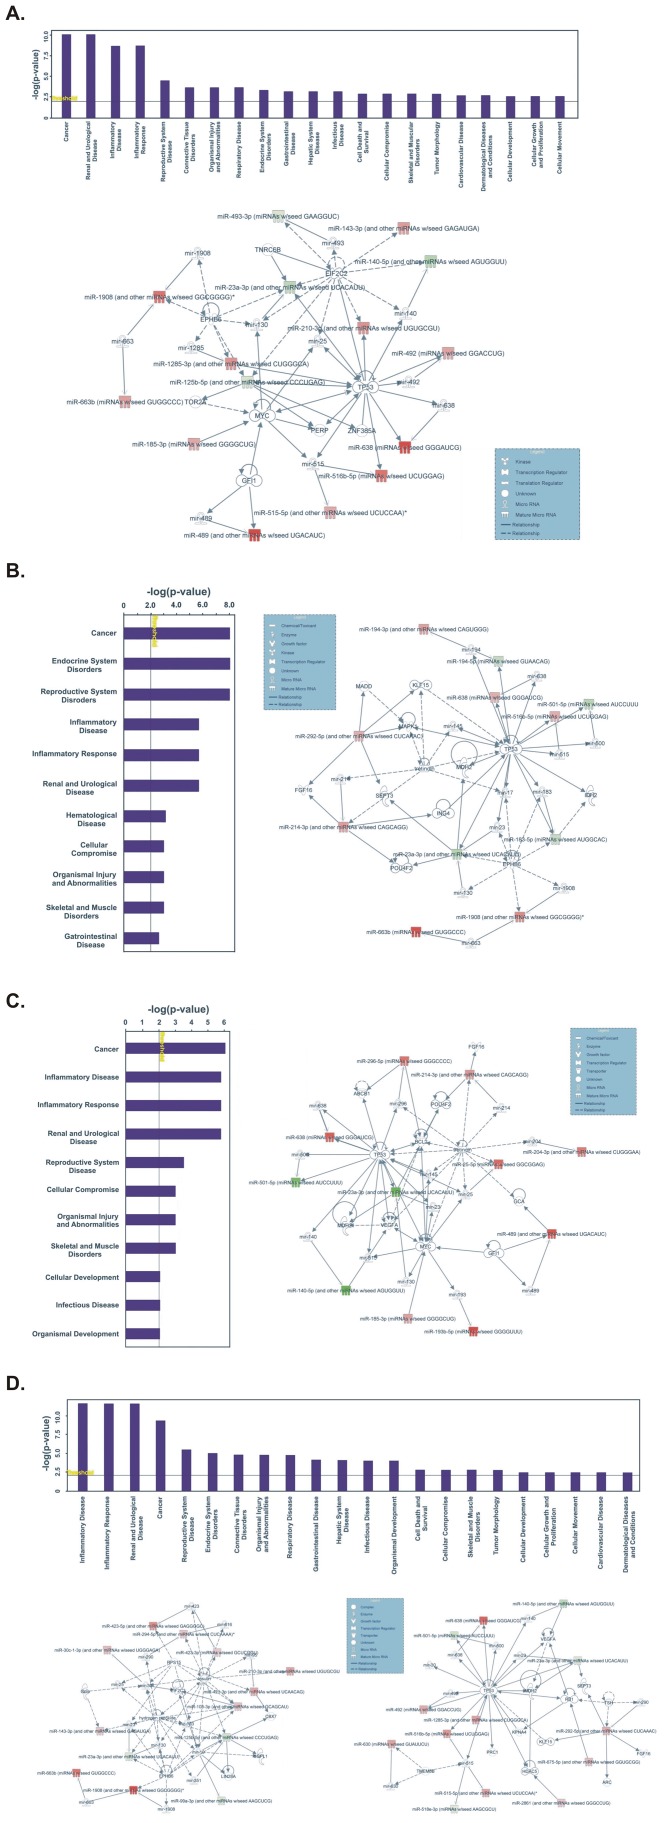
Ingenuity pathway analysis (IPA).A. In ccRCC, the most important biological functions of the top deregulated miRNAs were: 1) Cancer (p = 8.71E-11-4.91E-02); 2) Renal and Urological Disease (p = 8.71E-11-2.12E-09); 3) Inflammatory Disease (p = 2.12E-09-2.14E-03); 4) Inflammatory Response (p = 2.12E-09-2.4E-04) and 5) Reproductive System Disease (p = 3.37E-05-2.58E-02). The associated functions of the major miRNA network (score = 30) were: Inflammatory disease, inflammatory response, renal inflammation. Argonaute RISC catalytic component 2 (EIF2C2), tumour protein p53 (TP53), v-myc myelocytomatosis viral oncogene homolog (MYC) and EPH receptor B6 (EPHB6) constituted some of the major central nodes in this network. B. In papRCC, the most important biological functions of the top deregulated miRNAs were: 1) Cancer (p = 9.4E-09-4.15E-02); 2) Endocrine System Disorders (p = 9.4E-09-4.54E-02); 3) Reproductive System Disease (p = 9.4E-09-5.11E-03); 4) Inflammatory Disease (p = 2.17E-06-2.17E-06) and 5) Inflammatory Response (p = 2.17E-06-1.65E-03). The associated functions of the major miRNA network (score = 22) were: Endocrine System Disorders, Reproductive System Disease, Cellular Development. Tumour protein p53 (TP53) and EPH receptor B6 (EPHB6) constituted some of the major central nodes in this network. C. In chRCC, the most important biological functions of the top deregulated miRNAs were: 1) Cancer (p = 8.99E-07-4.73E-02); 2) Inflammatory Disease (p = 1.64E-06-1.64E-06); 3) Inflammatory Response (p = 1.64E-06-1.19E-03); 4) Renal and Urological Disease (p = 1.64E-06-7.96E-03) and 5) Reproductive System Disease (p = 3.02E-04-2.39E-02). The associated functions of the major miRNA network (score = 22) were: Hereditary Disorder, Skeletal and Muscular Disorders, Developmental Disorder. Tumour protein p53 (TP53), B-cell CLL/lymphoma 2 (BCL2) vascular endothelial growth factor A (VEGFA) and v-myc myelocytomatosis viral oncogene homolog (MYC) constituted some of the major central nodes in this network. D. In UT-UC, the most important biological functions of the top deregulated miRNAs were: 1) Inflammatory Disease (p = 2.7E-12-3.42E-02); 2) Inflammatory Response (p = 2.7E-12-1.75E-05); 3) Renal and Urological Disease (p = 2.7E-12-3.35E-09); 4) Cancer (p = 4.67E-10-4.53E-02) and 5) Reproductive System Disease (p = 3.82E-06-4.96E-02). The associated functions of the 2 major miRNA networks were: 1) Connective Tissue Disorders, Inflammatory Disease, Inflammatory Response (score = 25); and 2) Cancer, Reproductive System Disease, Renal and Urological Disease (score = 24). Insulin, hydrogen peroxide and ribosomal protein S15 (RPS15) constituted some of the major central nodes in the first network; whereas tumour protein p53 (TP53) constituted a central node in the second network.